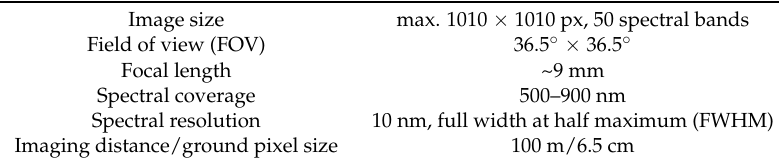
Table 4. Sensor specifications of the Senop Rikola hyperspectral